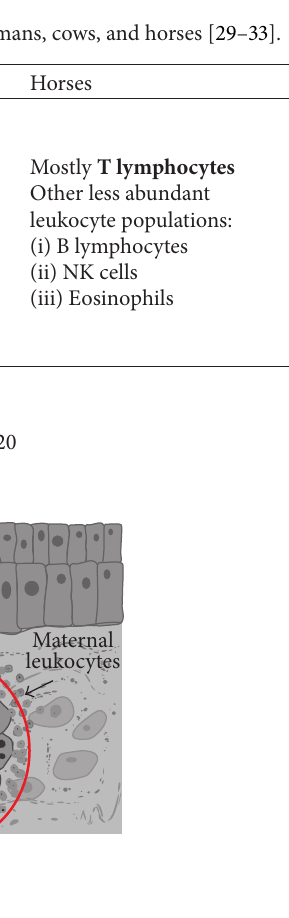
Figure 3: Expression of classical MHC I (ELA) proteins in the horse placenta. ELA are expressed only on the migrating chorionic girdle. Then ELA expression is downregulated when endometrial cups are created. After some time, the endometrial cups degenerate, and they have not been detected after day 120 of